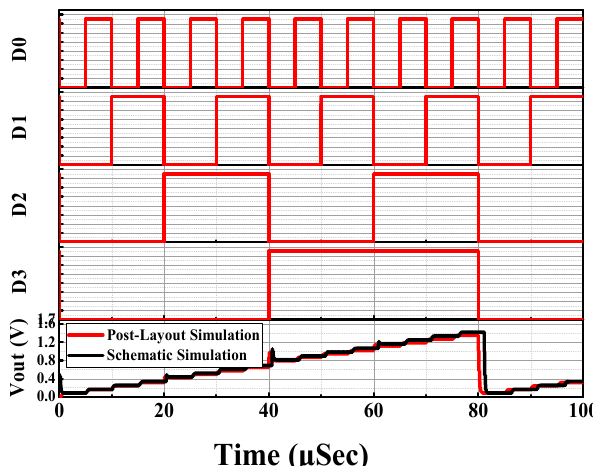
Figure 17. The simulation and post-simulation results of the output voltage levels of the proposed SSC-DVS.